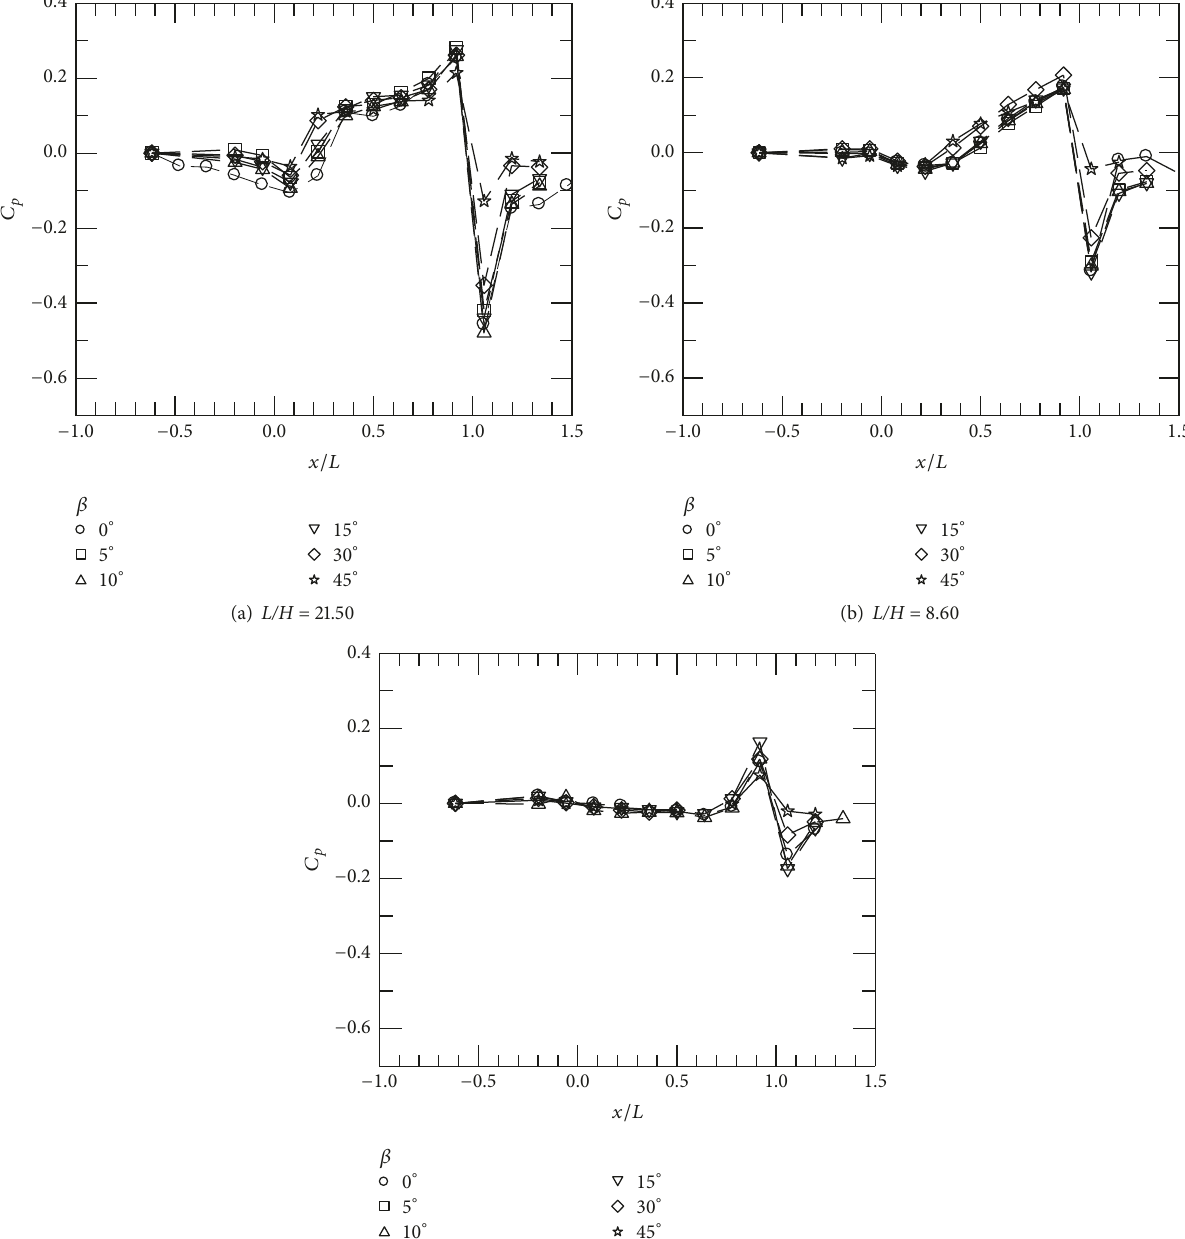
leading-edge expansion, compression on the cavity floor, and expansion near the rear face. The 𝐶 𝑝 distributions show that the boundaries for the flow type depend more on the value of L/H than on the value of 𝛽